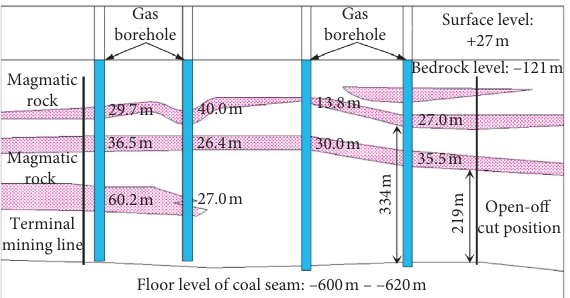
Figure 3: Sectional drawing of magmatic rock and borehole in panel 1061 [23].